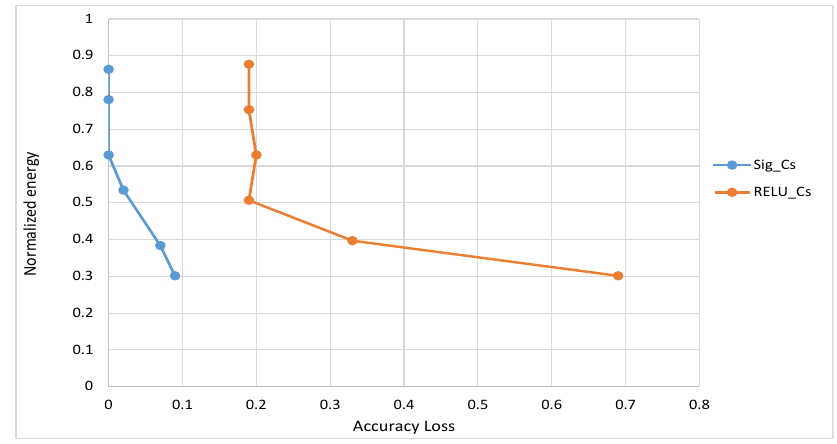
Figure 7. Comparison between Sigmoid and RELU in terms of Energy and Accuracy Loss.